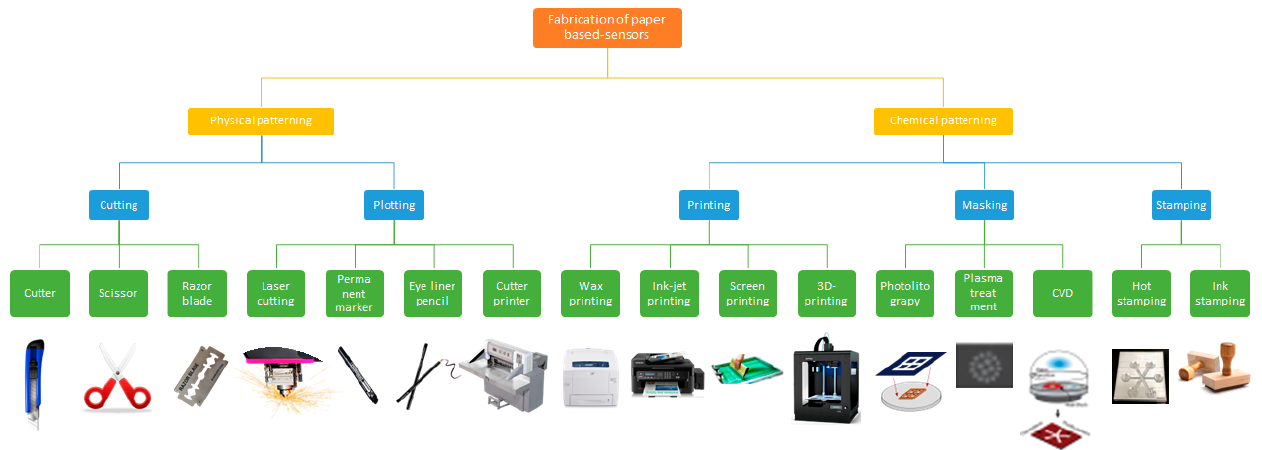
Figure 3. Patterning techniques that can be used for e-PAD biosensors, adopted from reference [54]. Open Access under CC BY-NC.